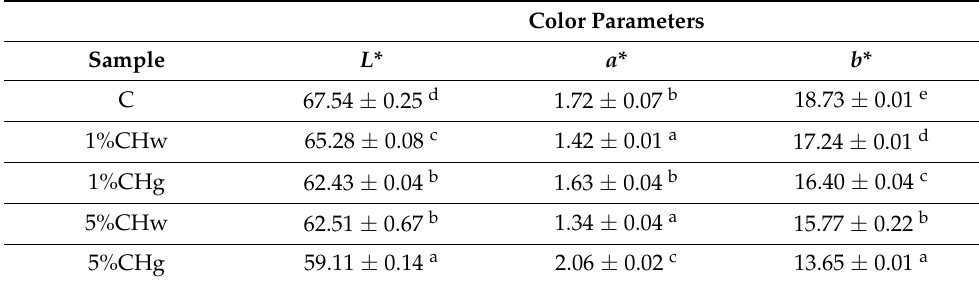
Table 6. Color parameters of the wheat bread with and without chia